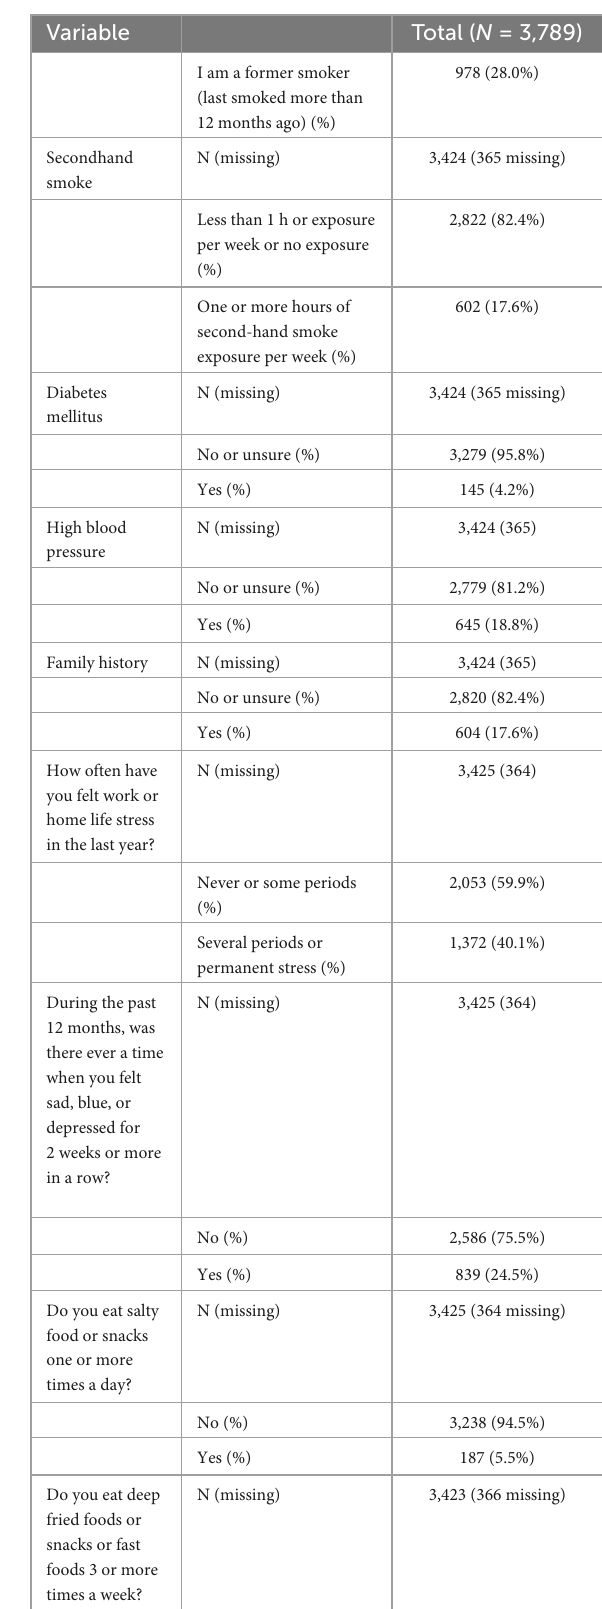
TABLE 1 Features of the 3,384 SPICES cohort